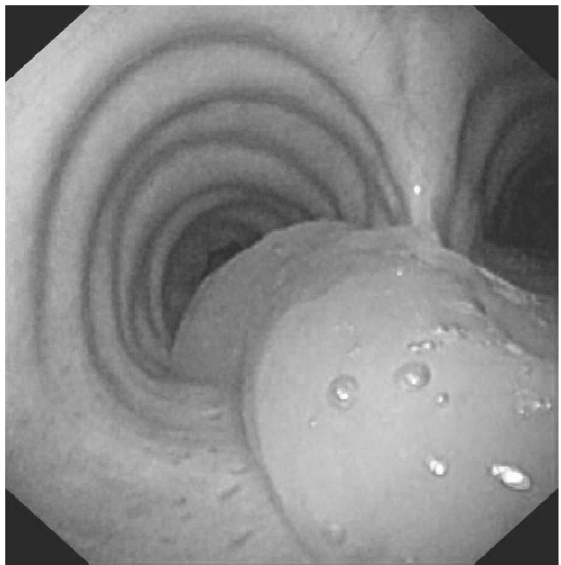
Figure 3. Bronchoscopy revealed a mass-like mucoid plug within the lower part of trachea and it continued up to the left upper lobe